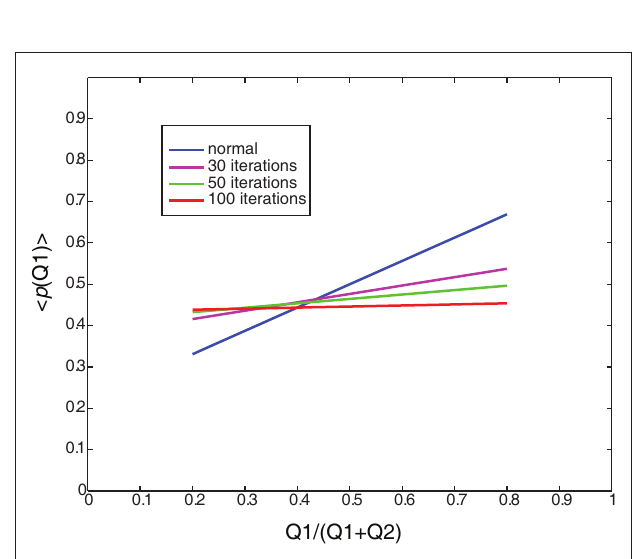
FigurE 4 | random learning: illustration of the average probability of choosing Q1 as a function of the ratio between Q1 and (Q1 + Q2) after 0 (normal), 30, 50, and 100 iterations of random learning. Random learning will eventually lead to a random policy (policy after 100 iterations, red curve).